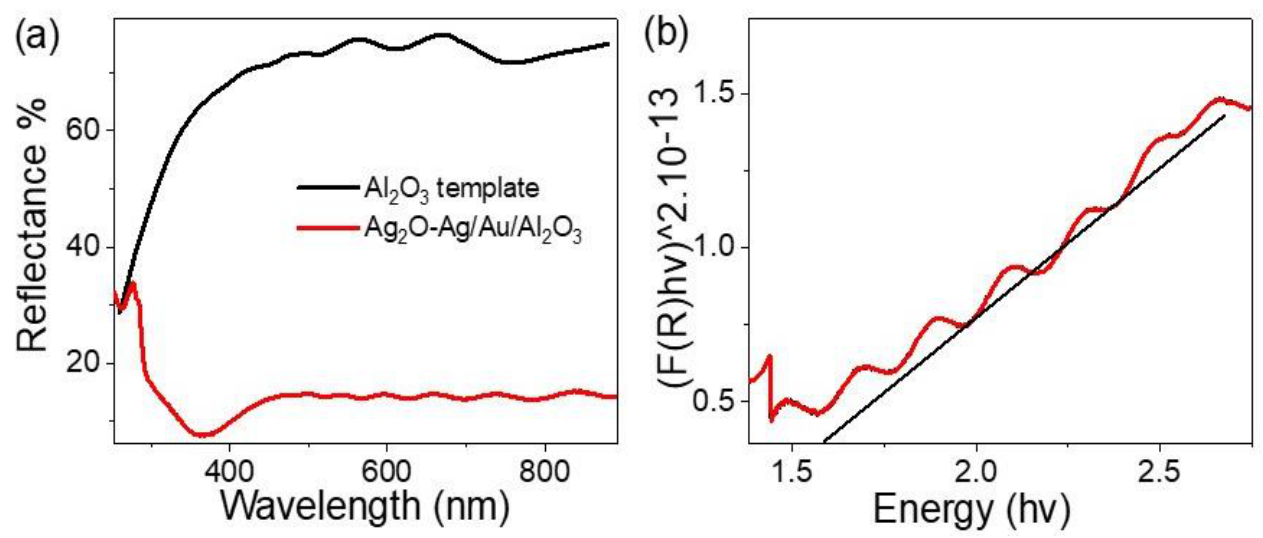
Figure 5. ( a ) Optical reflectance spectra of Al 2 O 3 and Ag 2 O-Ag/Au/Al 2 O 3 and ( b ) band gap value of Ag 2 O-Ag/Au/Al 2 O 3 nanomaterials.